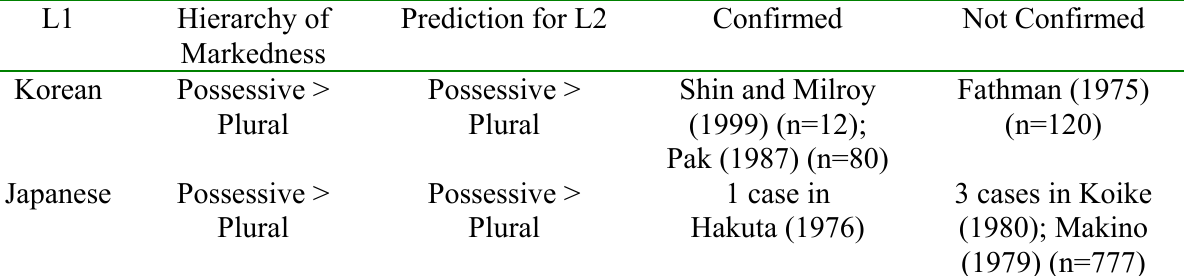
English L2 Plural -s and Possessive –’s in Group A